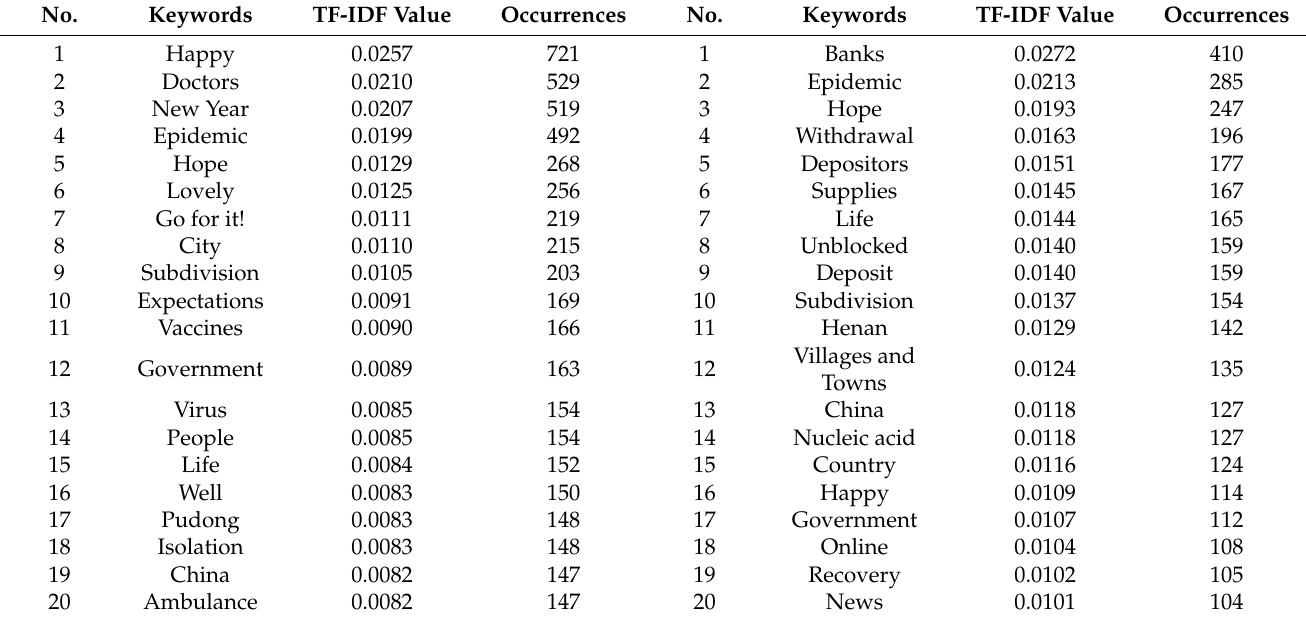
Table 6. Top 20 ranked keywords for C1 and